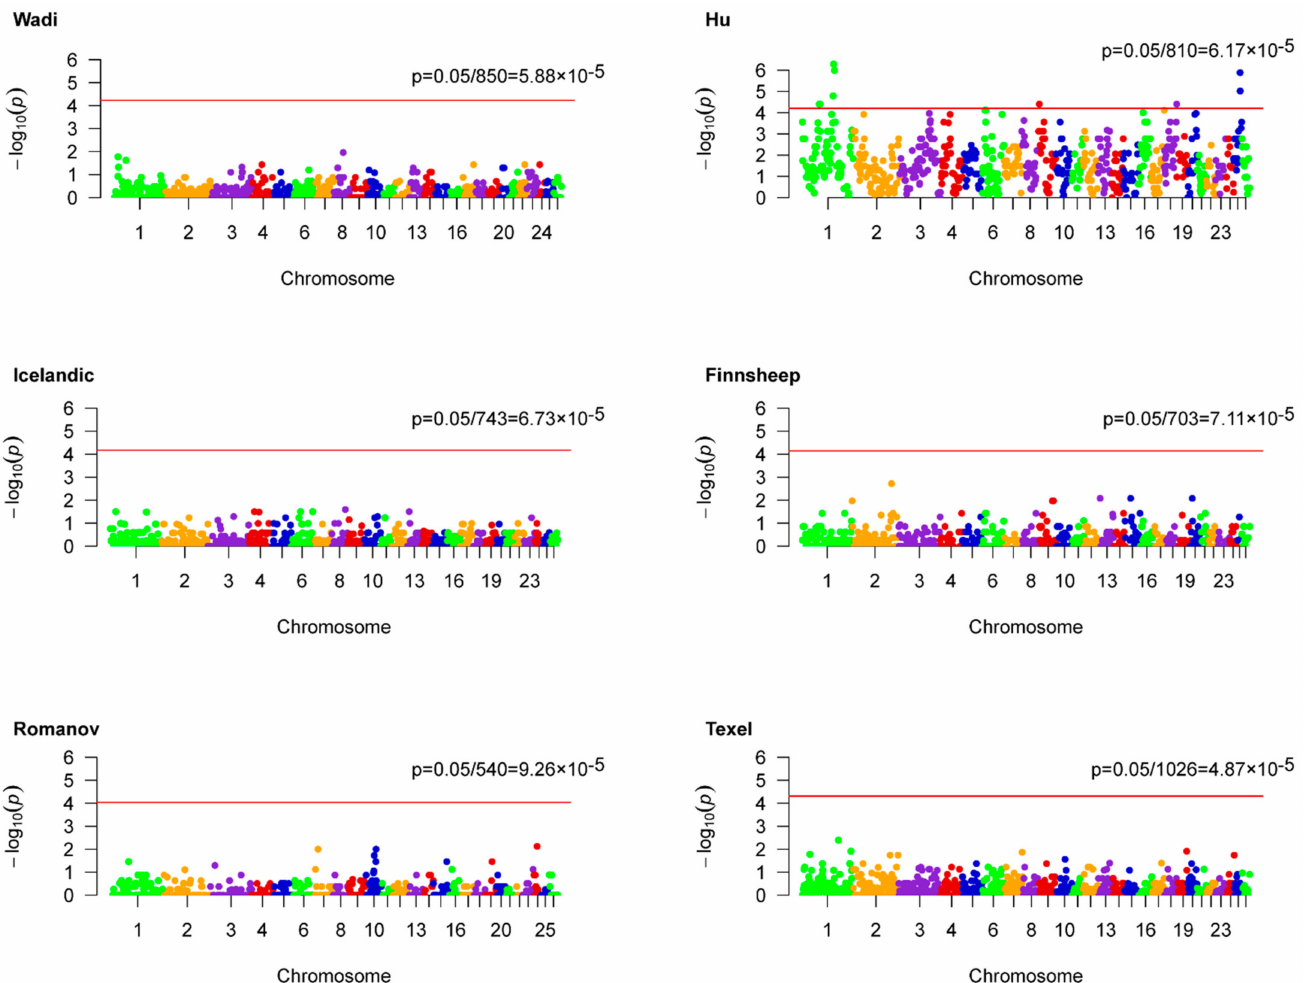
Figure 2. Genome-wide ROH hotspots associated studies for litter size in six sheep breeds. The red lines denote the thresholds used to extra